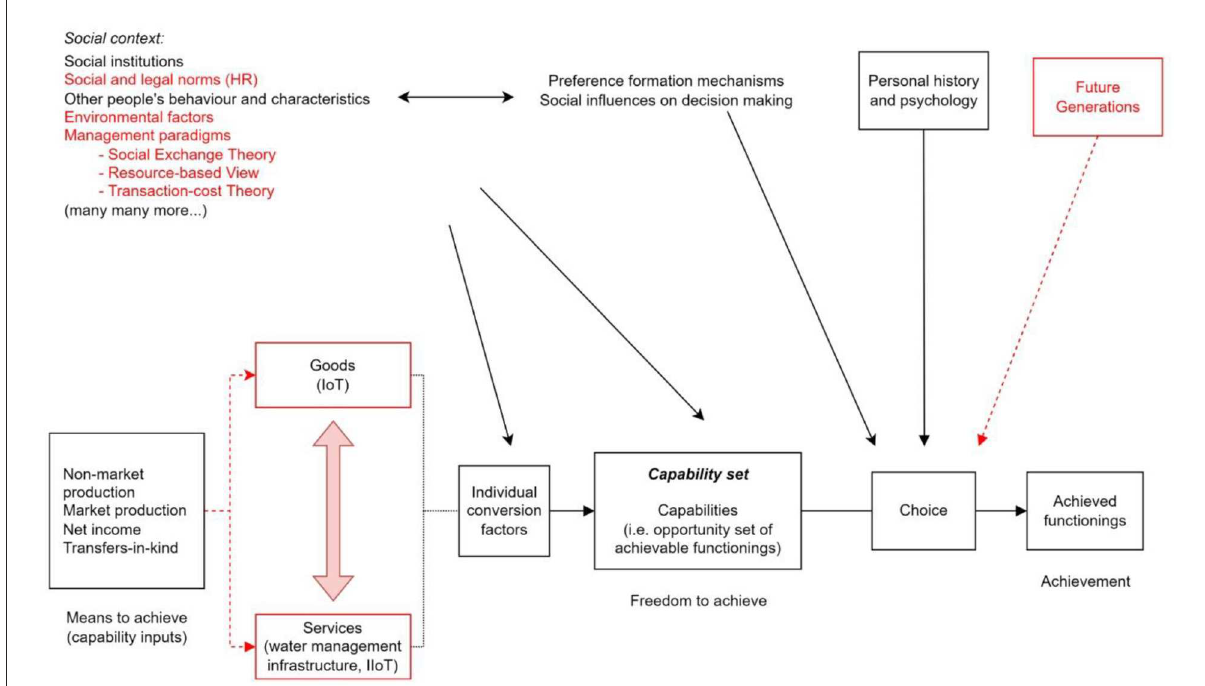
FIGURE5 Capabilities Approach applied to data-driven water systems based on the graph by Robeyns (2005), p. 98. The highlighted sections in red are specifications and adjustments by the authors to the framework, applicable to data-driven water management systems policy. The figure also highlights the issue of the separation of goods and services, as a side-effect of data-driven water management, discussed